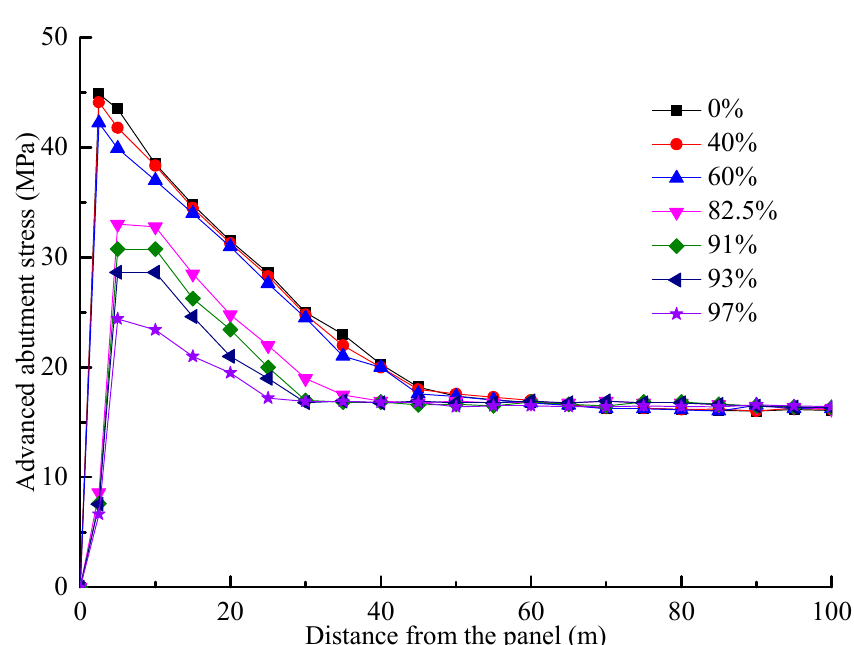
Figure 9. Comparative analysis of advanced abutment stress for different roof-controlled backfill ratios. As shown in Figures 8 and 9, the distributions of the advanced abutment stresses in the backfill panel are similar to those in the mining panel found when using a caving method (i.e., when the roof-controlled backfill ratio is zero): along the direction of the working panels, an unloading zone, a pressure elevation zone, and an at-rest stress zone are shown: